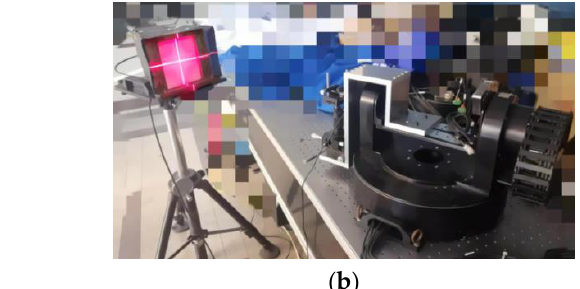
was coaxial with the turntable axis, the laser position is adjusted. That is, the center of cross laser image does not change in the image coordinate when rotating the turntable. The measurement principle is shown in Figure 18. Figure 18. Schematic diagram of the experiment principle. In order to express conveniently, the cross laser only draws the X axis laser line. Here, 0  is angle of the laser line at the initial moment in the image coordinate system and 1  is the angle of laser line in the image coordinate system after rotation. m  represents the rotation angle measured by the image acquisition system and r  represents reference value of the rotation angle obtained from the turntable system. Since the projection axis of cross laser cannot be guaranteed to be perpendicular to the receiving screen of the im- age acquisition system, the projection error will be introduced into the measurement [26], and e represents the measurement error. The correlation is shown in Table 2: Table 2. Correlation of the parameters. Measurement Value